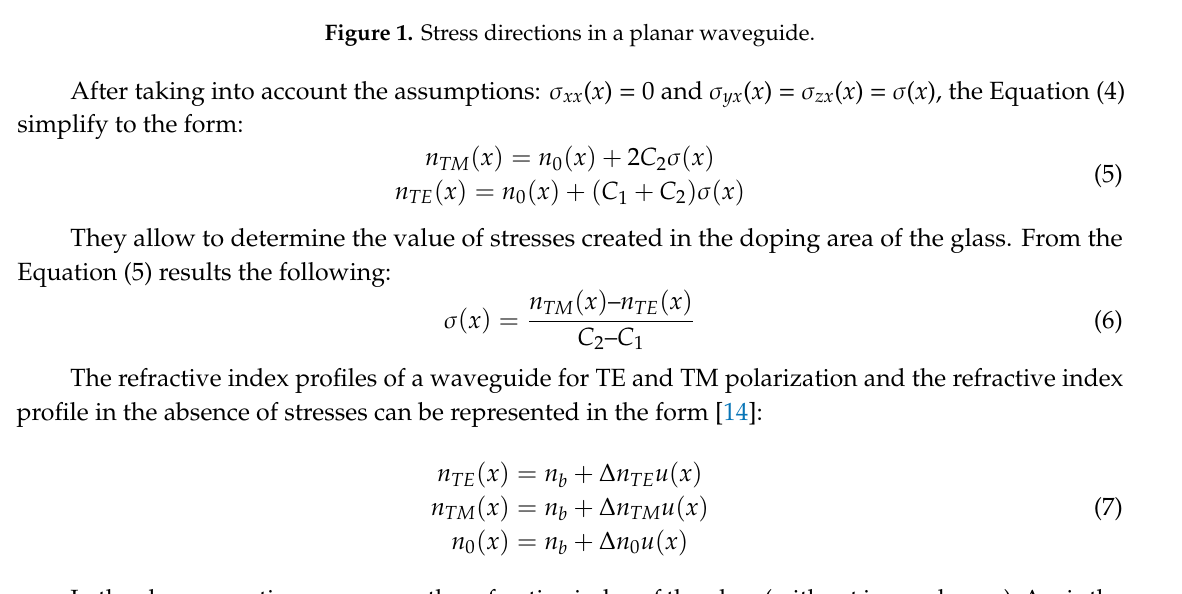
Figure 1. Stress directions in a planar waveguide.